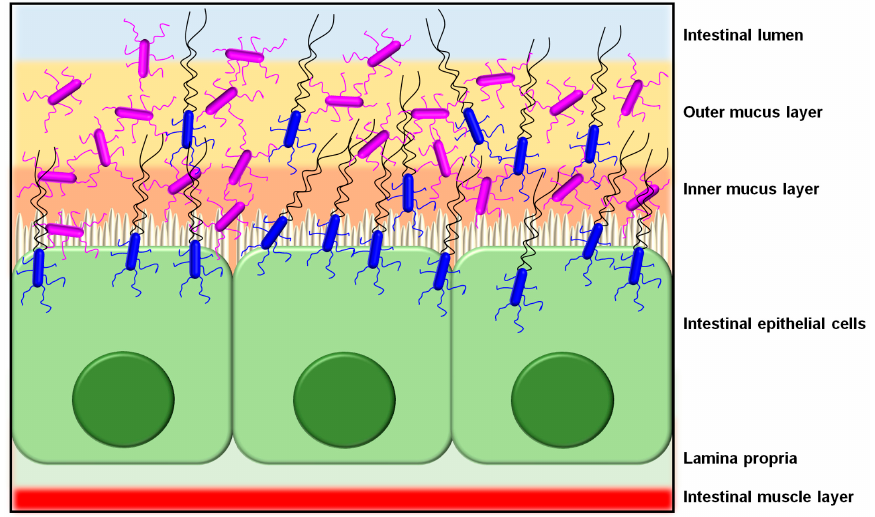
Figure 4. Schematic depiction showing the presumptive binding of piliated lactobacilli to the intestinal mucosa epithelium. Based on substrate-binding capacities, L. rhamnosus cells (purple) with their mucoadhesive SpaCBA pili would be predominantly found within the outer and inner mucus layers, whereas flagellated L. ruminis cells (blue) would be able to maneuver through this mucosal barrier and then, via their ECM-binding LrpCBA pili, attach themselves to the single cell layer of intestinal epithelial tissue. This cartoon image is representative only, and includes various aspects and features that are not drawn to scale.